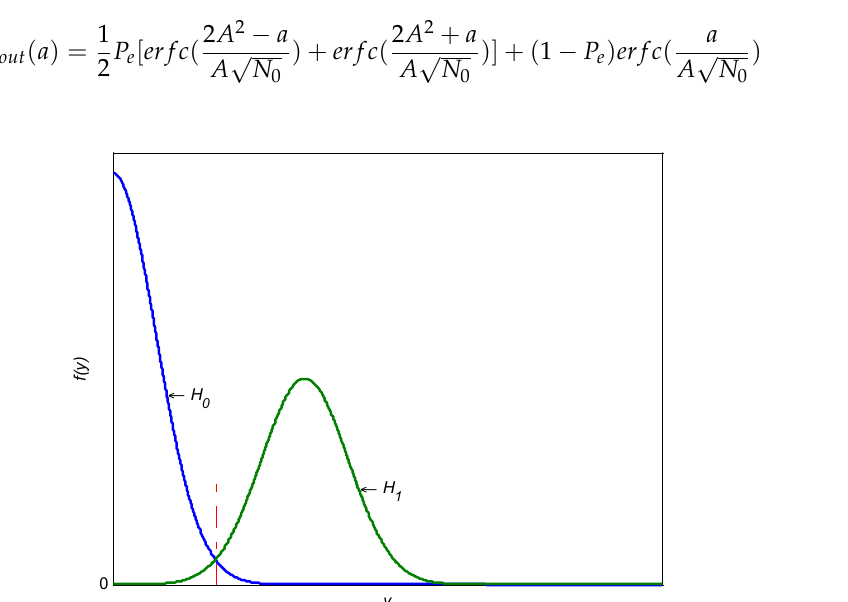
Figure 3. The probability density functions of two statuses.